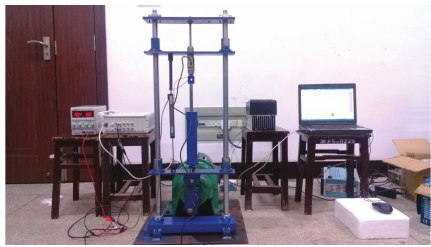
Figure 7: The vibration test system of MRD.